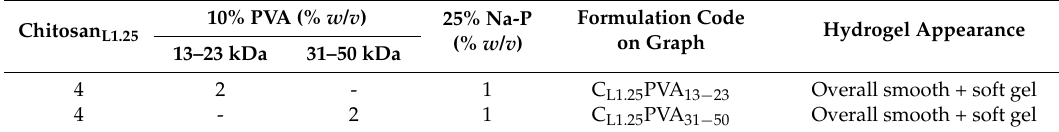
Table 2. Composition of stable hydrogel formulations grouped according to chitosan concentration and viscosity.